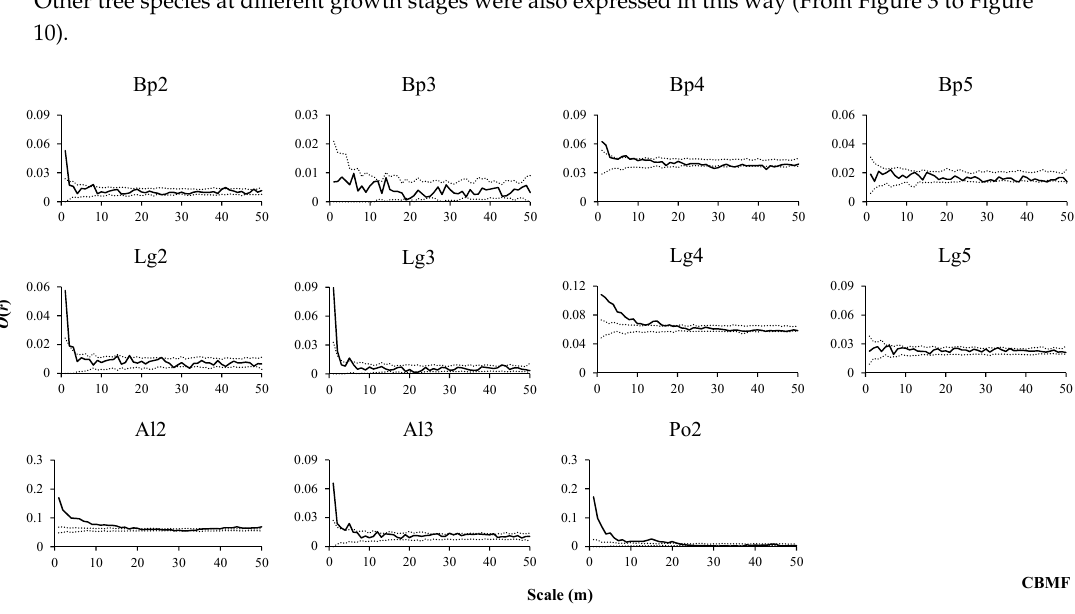
Figure 3. Spatial distributions of tree species in CBMF.